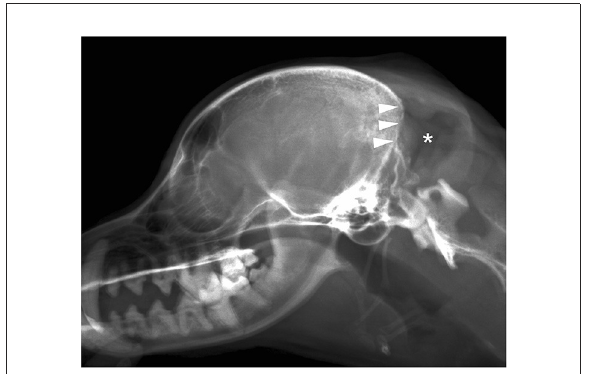
FIGURE1 Plain X-ray film of the lateral view of the head. Radiolucent mass shadows in the occipital region (*) and opacification of the occipital bone (arrowhead) were